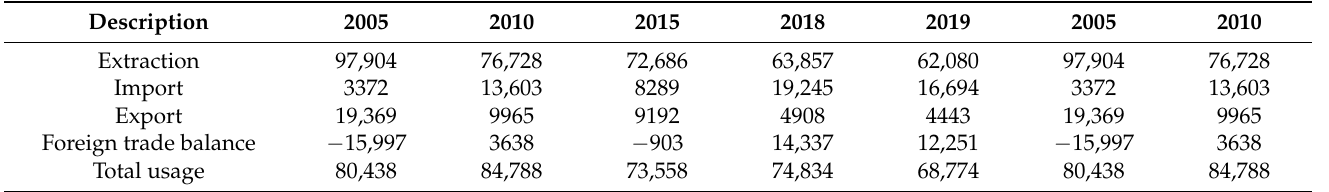
Table 2. Selected components of hard coal balances in Poland (millions of